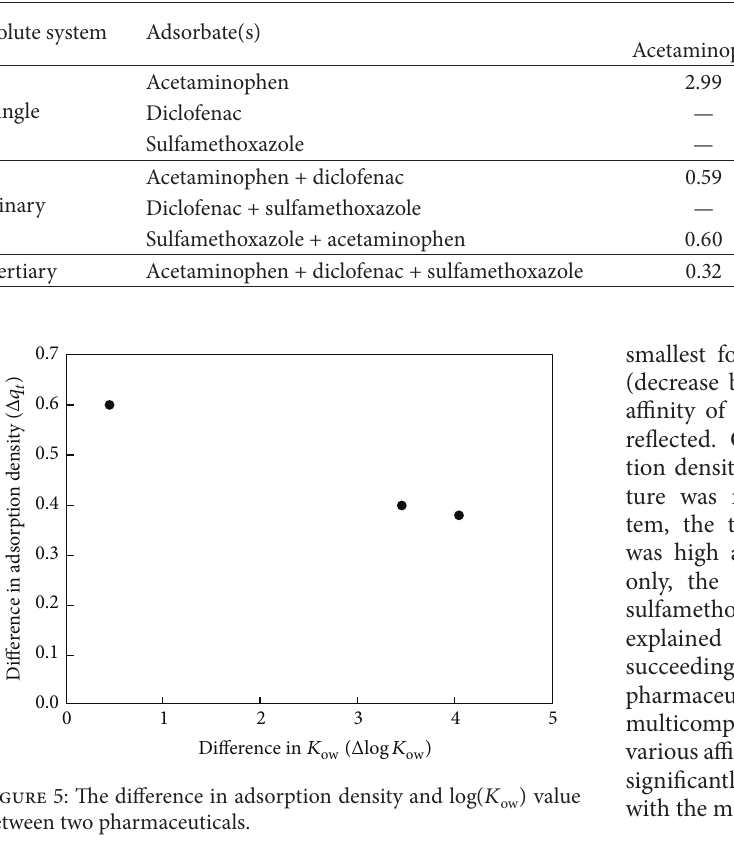
Figure 5: The difference in adsorption density and log (𝐾 between two